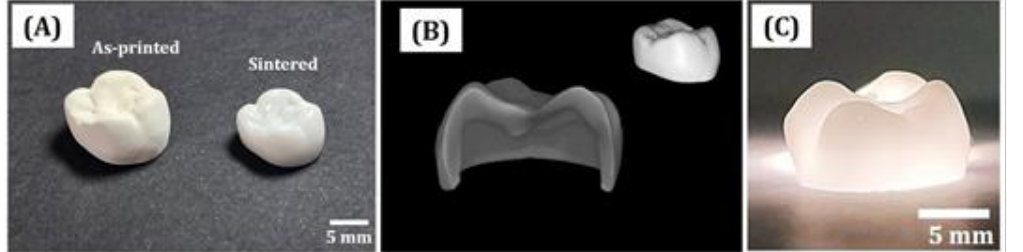
Figure 16. ( A ) Optical image showing 3D geometries of as-printed and sintered dental crowns, ( B ) representative μ -CT image of a sintered dental crown, and ( C ) optical image showing translucency of a sintered dental crown under light illumination.